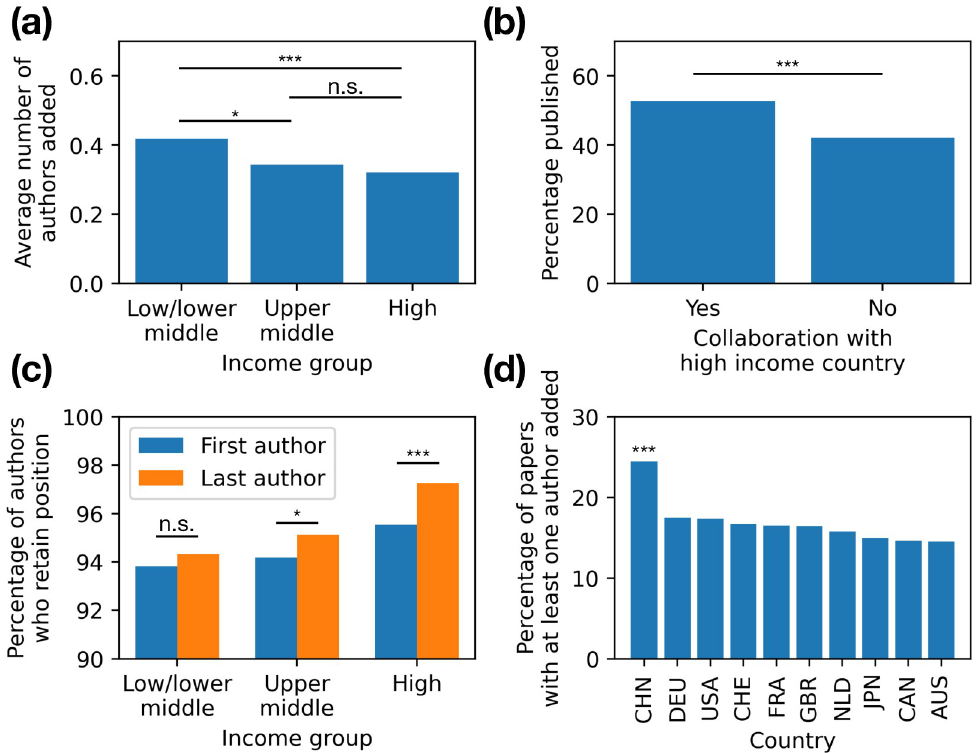
Fig 5. Authorship analysis. (a) Average number of authors added from preprint to paper for each income group. Preprint-paper pairs with 10 or more author changes were excluded. (b) Percentage of preprints published from upper middle or low/lower middle income countries where there is at least one other author on the preprint from a high income country or not. (c) Percentage of authors who retain their position from preprint to paper for each income group and for first and last author positions. (d) Percentage of papers where at least one author was added from preprint to paper publication by country. ��� p < 0.001, � p < 0.05, n.s. not significant.